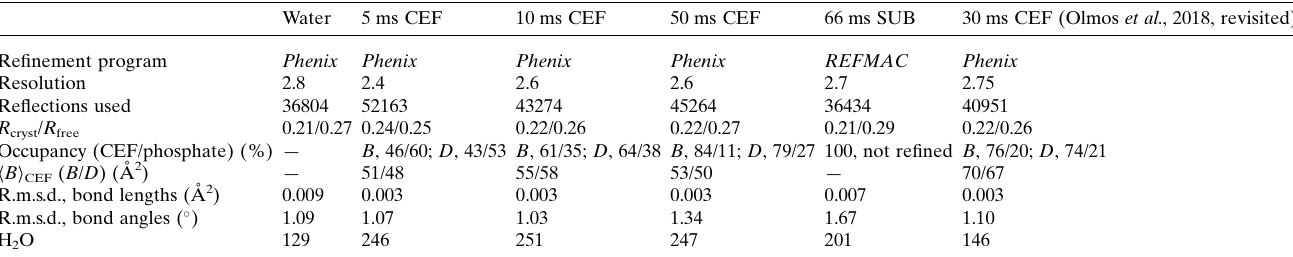
Table 3 Refinement